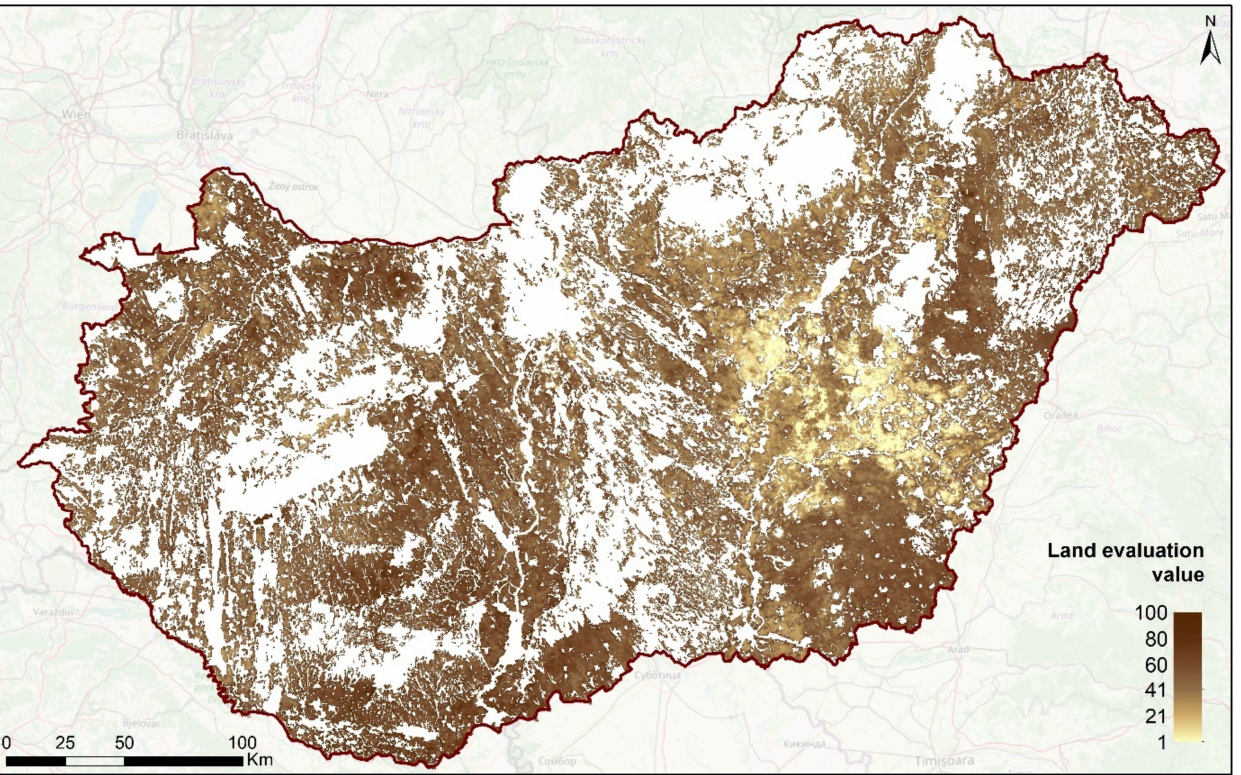
Figure 5. Croplands’ land evaluation values range between 0 and 100 in the case of general biomass productivity of arable lands after slope